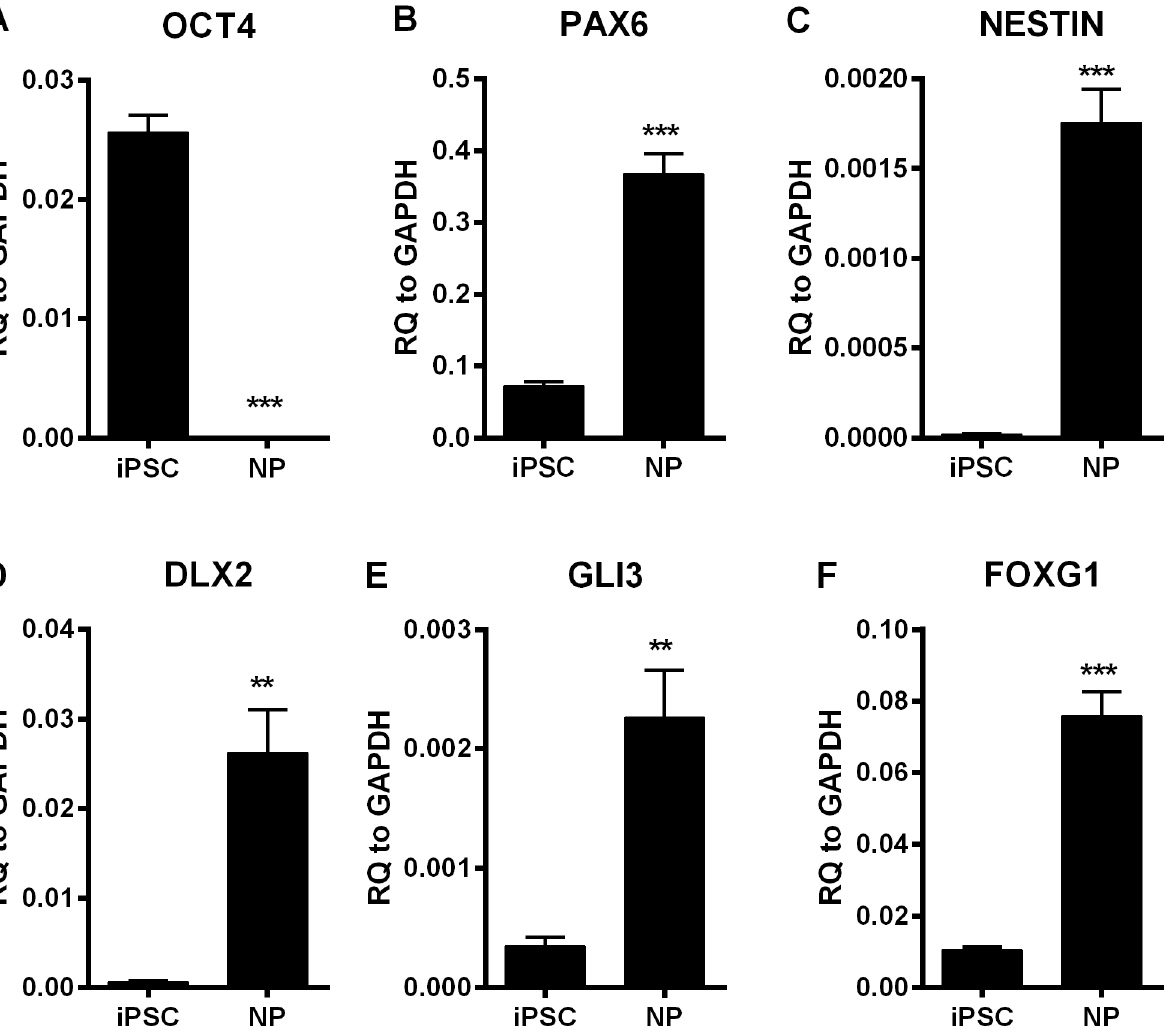
Fig 2. Quantitative RT-PCR of RNA samples from iPSCs and NPs. RNA samples were collected from iPSC and NPs and gene expression of markers of developmental stages were evaluated. Changes in pluripotency and neuroprogenitor markers were measured (A-F). Each bar represents mean ± standard error, n = 8. Statistical analysis was performed using unpaired student t-test . *** p < 0.0001, ** p <